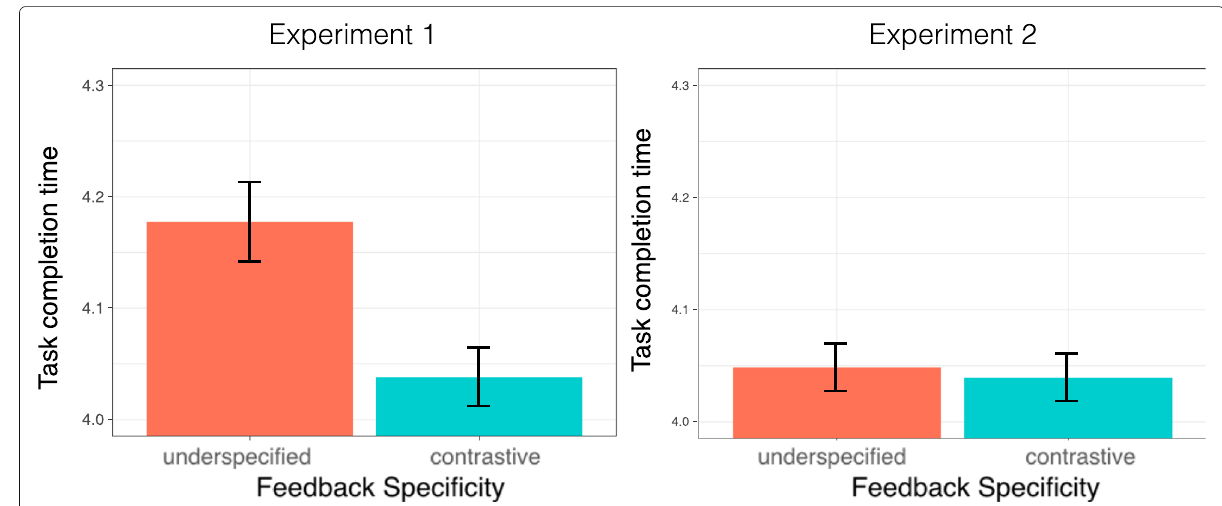
Fig. 7 Total time for the interactions for Experiment 1 with ambiguous instructions (left) and for Experiment 2 (right)